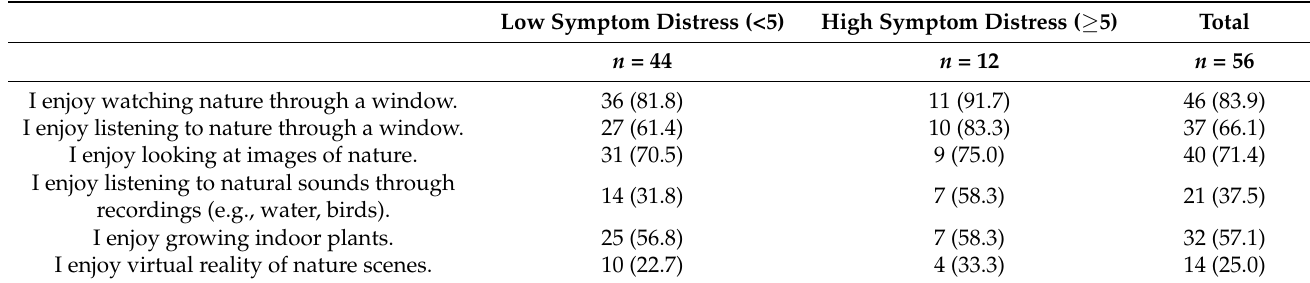
Table 3. Alternatives to engagement with outdoor nature, by level of symptom